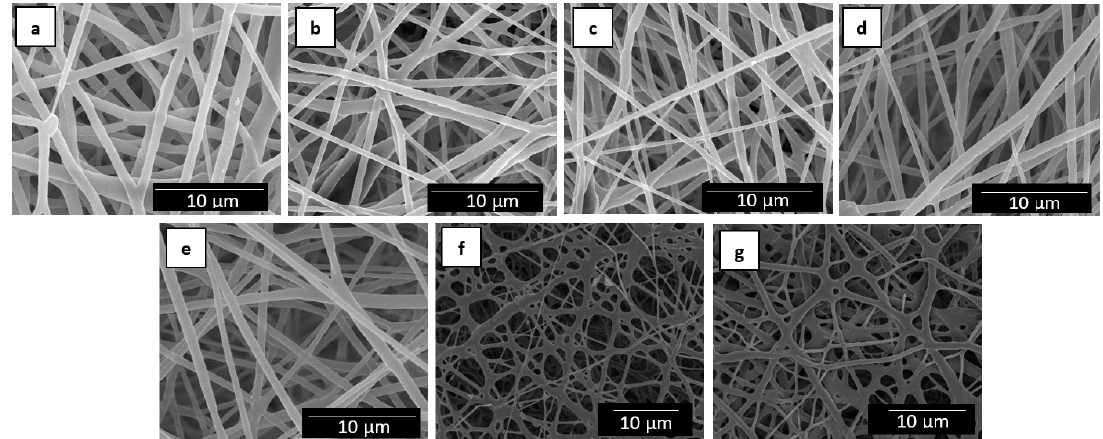
7 of 24 Figure 1. Scanning electron microscopy (SEM) images of: ( a ) Mobil Composition of Matter (MCM-41); ( b ) MCM-41 with eugenol. Scale markers of 1 µm. Transmission electron microscopy (TEM) images of: ( c ) MCM-41 and ( d ) MCM-41 with eugenol. Scale markers of 100 nm. Figure 2 shows the resultant electrospun mats obtained from the neat PHBV solution and the different solutions of PHBV/MCM-41 with eugenol. One can observe that, in all cases, the electrospinning process generated a mat composed of non-woven fibers with a similar morphology. Table 1 summarizes the mean diameters of the electrospun fibers. The neat PHBV fibers without MCM-41, processed in the same conditions, presented a mean diameter of 0.89 ± 0.30 µm. It can be observed that the mean diameters of the electrospun fibers varied in the 0.6–0.7 µm range when the silica particles were incorporated. However, one can observe that the electrospun fibers with the